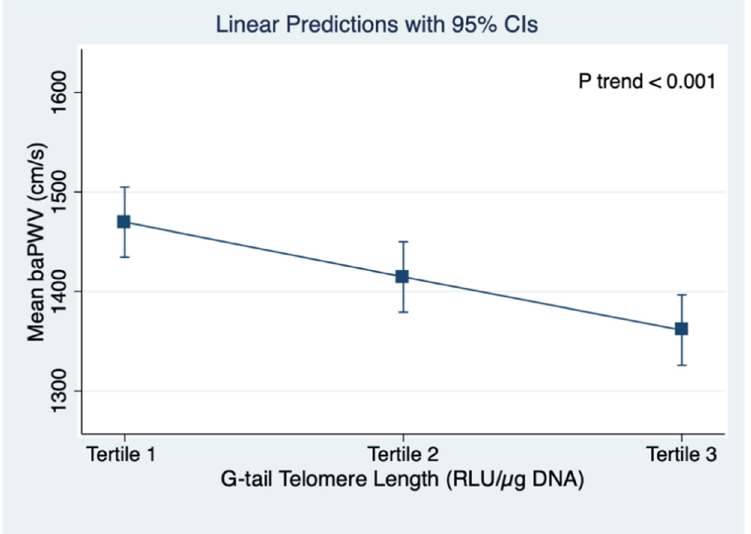
Figure 2. Linear regression predictions of mean baPWV and G-tail telomere length across the tertiles of G-tail telomere length; baPWV: brachial–ankle pulse wave velocity; CI: confidence intervals. Tertile 1: 11854.32~29611.05 RLU/ μ g DNA, Tertile 2: 29611.05~33409.38 05 RLU/ μ g DNA, and Tertile 3: 33409.38~53575.0605 RLU/ μ g DNA).